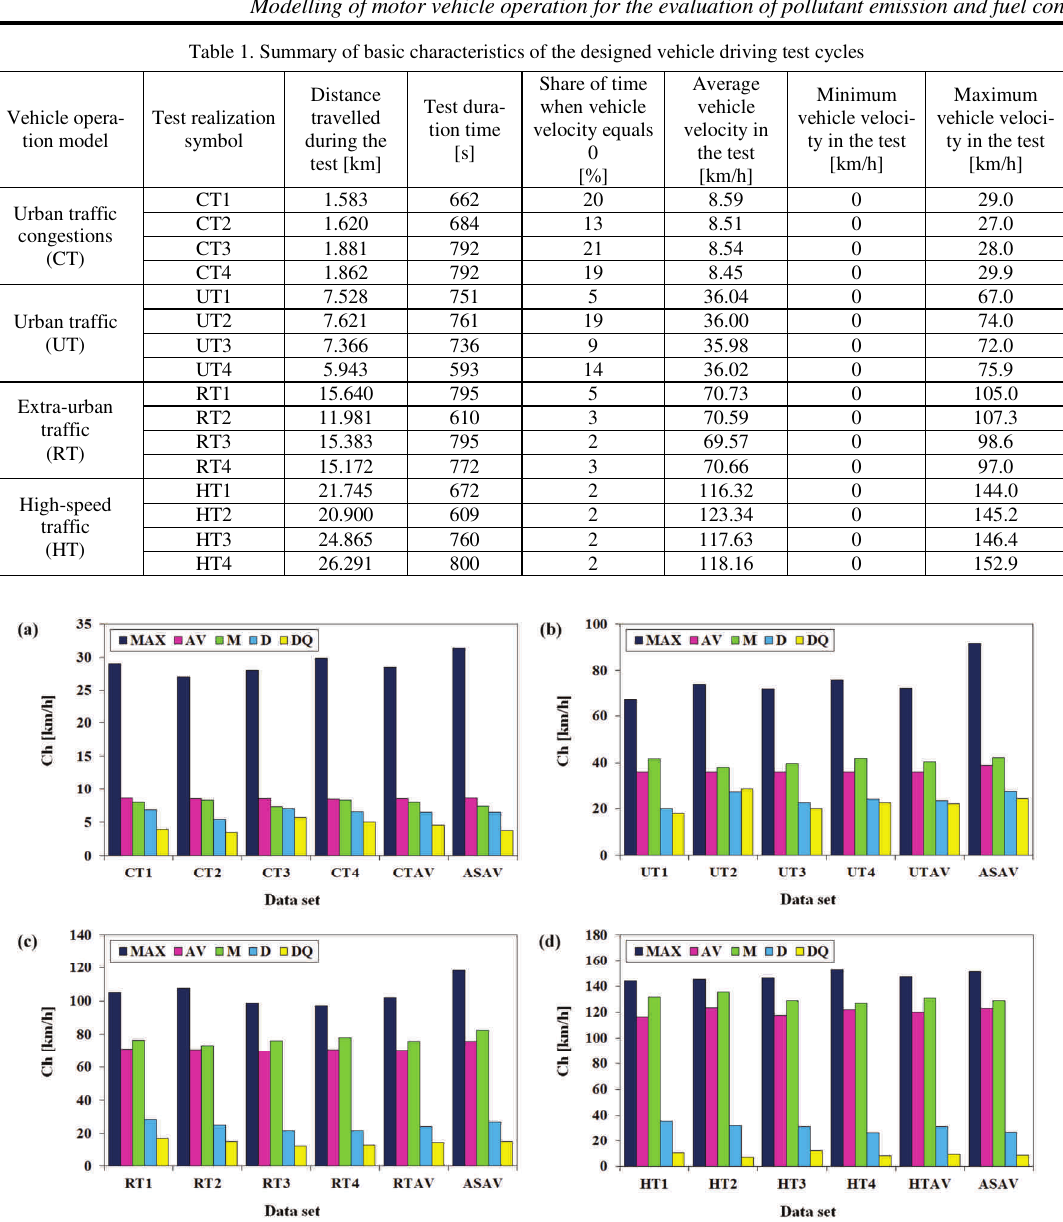
Fig. 3. Characteristics of the velocity process realizations in individual driving cycles, in sets of four cycles of the same category, and in all the velocity samples collected: a) urban traffic congestions (CT); b) urban traffic (UT); c) extra-urban traffic (RT); d) high-speed traffic